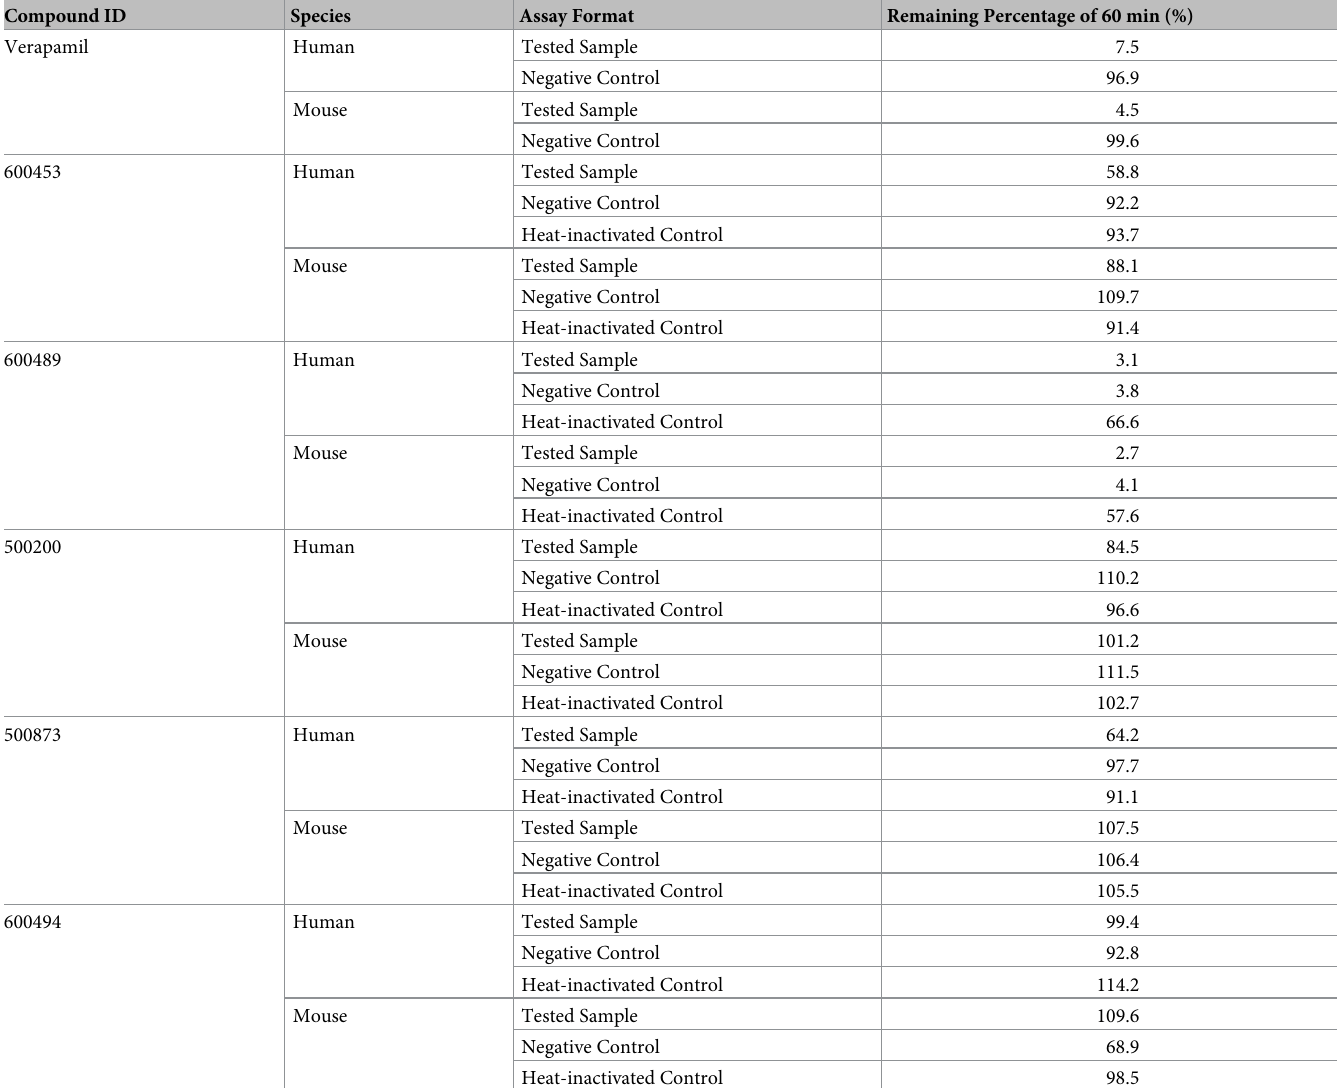
Table 1. Metabolic stability of phenylbenzamides in human and male mouse liver microsomes. Compound